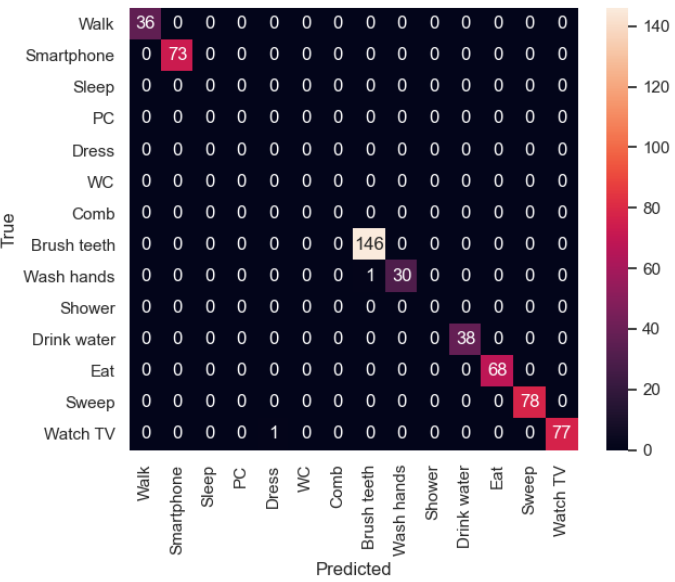
Figure 25. Sequence 2-Experiment 1-Confusion Matrix.